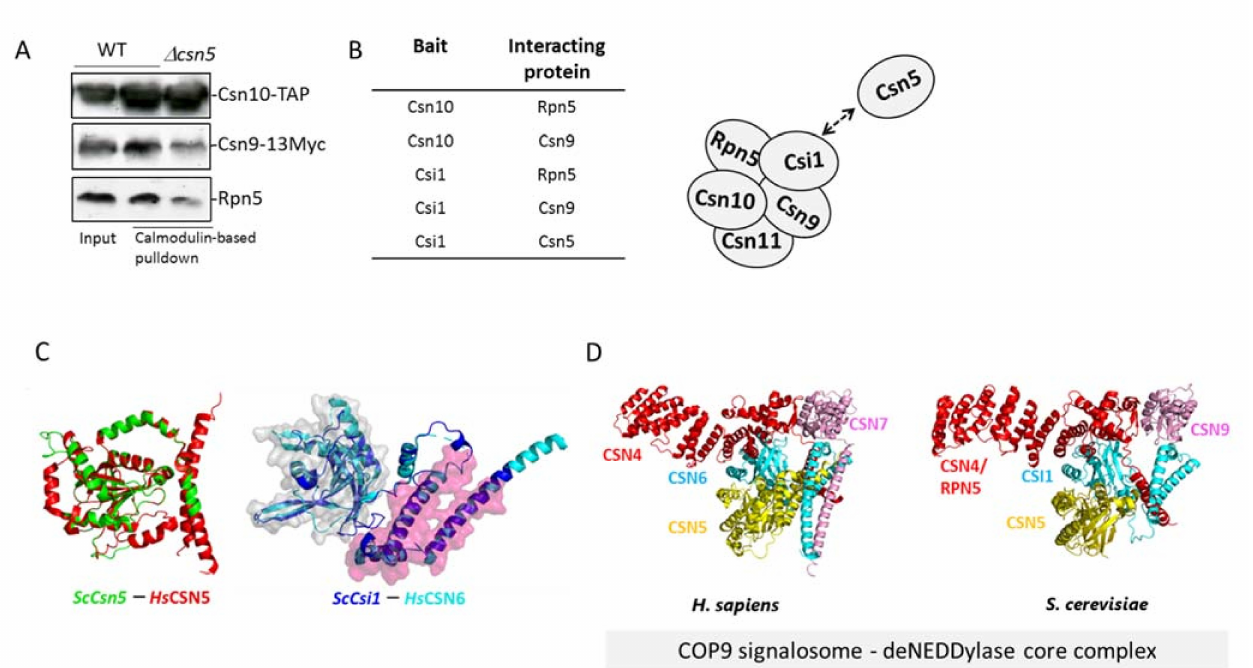
Figure 2. Interactions between the S. cerevisiae CSN subunits. ( A ) The pulldown of CSN10-TAP through calmodulin affinity resin from wildtype and ∆ csn5 mutant cells used to evaluate subunit interactions through immunoblotting for Rpn5 (by Rpn5 antibodies) and Csn9-13Myc (by Myc antibodies). ( B ) A summary of the findings in Figure 2A and Figure S2. ( C ) Superimposition of the S. cerevisiae Csn5 (green) and Csi1 (blue) homology models with their corresponding H. sapiens CSN5 and CSN6 template structures (Red and cyan respectively, PDB ID 4D10). Gray and pink surface representation is shown for the CSN6/Csi1 MPN domain (residues 35-145 in CSN6) and S6CD domain (residues 215–295 in CSN6), respectively. ( D ) Empirical 3D structure of the human and S. cerevisiae CSN deNEDDylase core complexes. S. cerevisiae homology models were built using Swiss-Model for Csn5, CSN4/Rpn5, and CSN7/Csn9, or by Phyre 2 for Csi1, as described in Table 1 and in the Supplemental Alignment. Note that residues that are not aligned with the sequence of the template are not shown in this predicted comparative